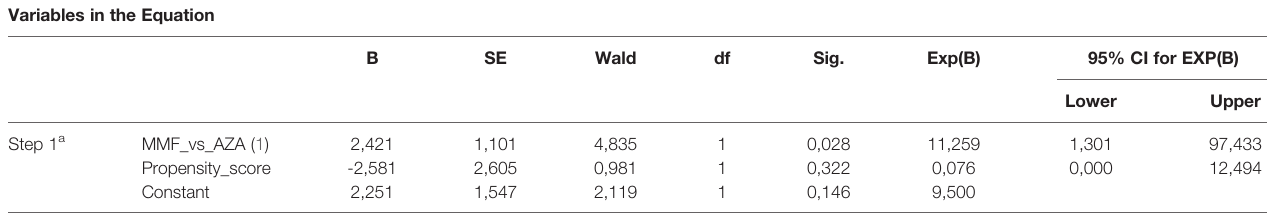
TABLE 3 | Binary logistic regression for estimating the effect of type of treatment on response to treatment. Variables in the